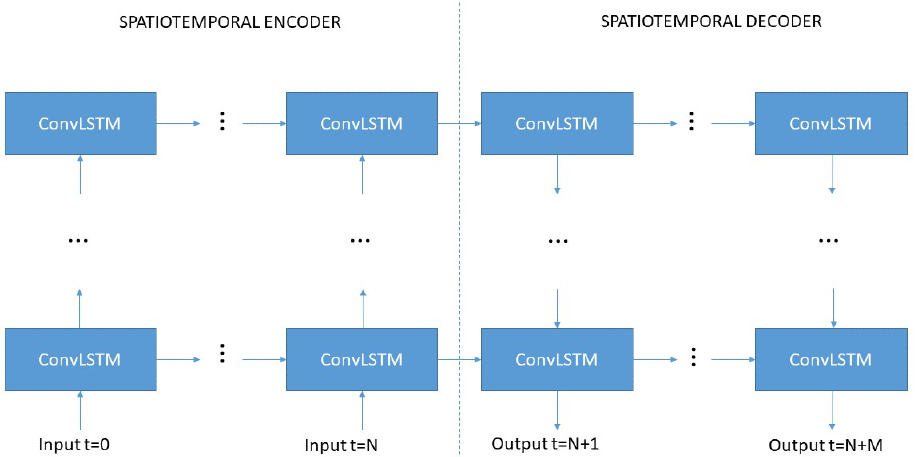
Figure 2. Illustration of the stacked ConvLSTM architecture. ConvLSTM is a type of recurrent neural network for spatiotemporal prediction that has convolutional structures in both the input-to-state and state-to-state transitions. The ConvLSTM determines the future state of a given cell in the grid by the inputs and past states of its local